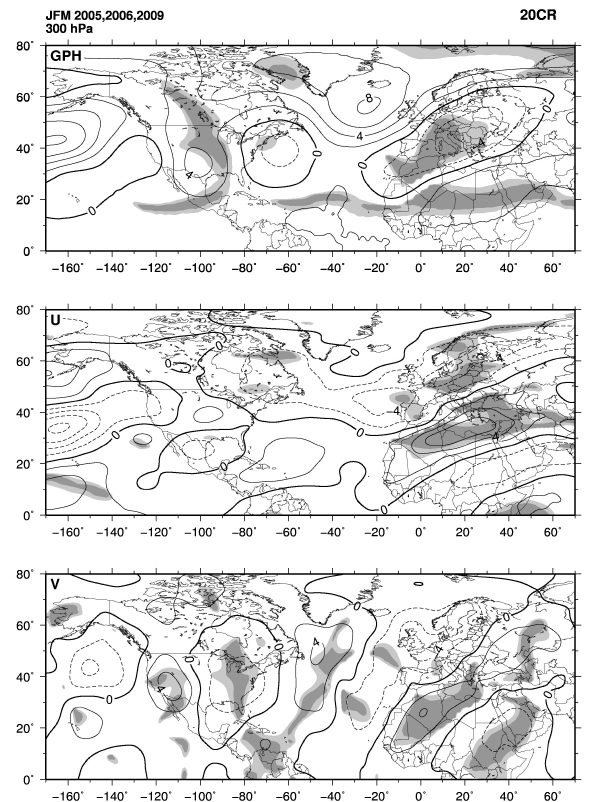
Fig. 13. Average anomalies (with respect to 1951–2000) in JFM during the years 2005, 2006 and 2009 in 20CR for geopotential height (top panel, in dam), zonal wind (middle panel, in ms − 1 ) and meridional wind (bottom panel, in ms − 1 ). Shadings represent statistical significance like in the previous